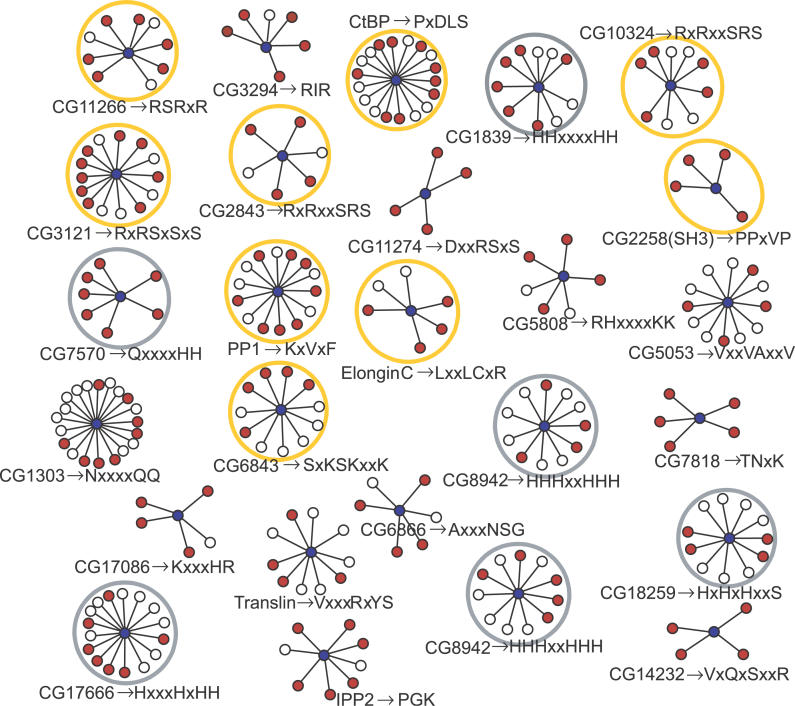
Overview of Motifs Found in the FlySignificant predictions from the yeast two-hybrid set for the fly. Blue dots in the center of each cluster represent proteins with four or more interaction partners (red and white dots) containing at least one confidently predicted motif (p-value < 0.001; Scons ≤ 8 × 10−15). Partner proteins containing the motif are represented by red dots, whereas proteins lacking the motif are indicated by white dots. Clusters are labelled as gene name→detected motif. Yellow circles enclose known motifs: SH3→PxxP [38], PP1→RVxF [22], C-terminal binding protein (CtBP)→PxDLS [52], SR splicing factors RS-rich segments [53], and CG6843→SxKSKxxK, a likely nuclear localization signal. The Translin→VxxxRxYS motif was experimentally tested (Figure 3). The grey circles enclose clusters with low-complexity patterns. Two additional known motifs were also found in the fly using more relaxed criteria than those used for the other motifs in the figure: Groucho→WRPW [7] and Dynein light chain→TQT [26] as the variant A(TI)QT(DE). The latter was also identified as significant in the domain sets. Proteins are denoted either by their FlyBase accession codes or protein names when available.